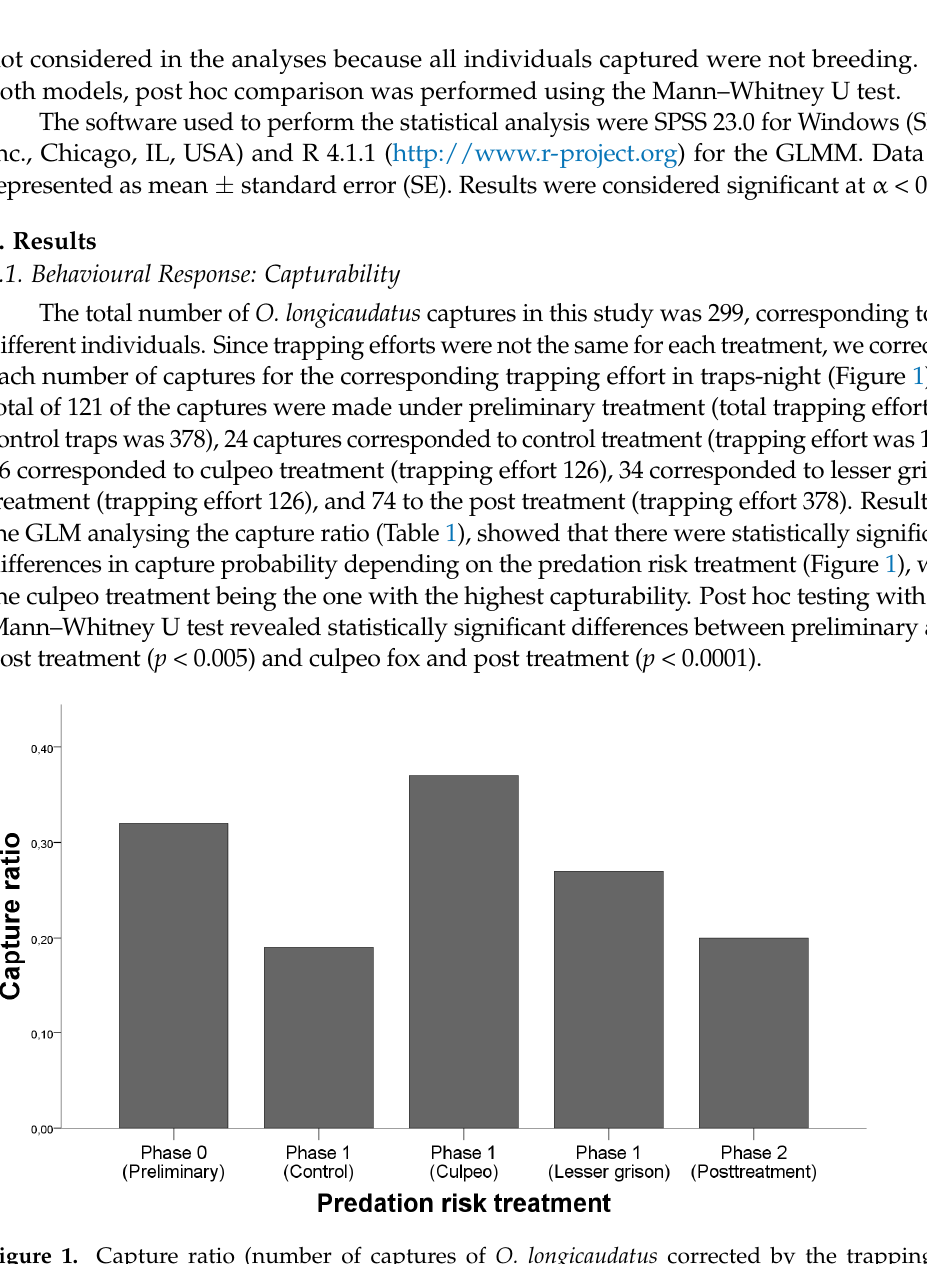
Figure 1. Capture ratio (number of captures of O. longicaudatus corrected by the trapping effort in traps-night) depending on the predation risk treatment (Phase 0 — Preliminary/Phase 1 — Control/Phase 1 — Culpeo/Phase 1 — Lesser grison/Phase 2 — Post treatment). Table 1. Results of the GLM, analysing the effects of experimental and environmental factors on O. longicaudatus